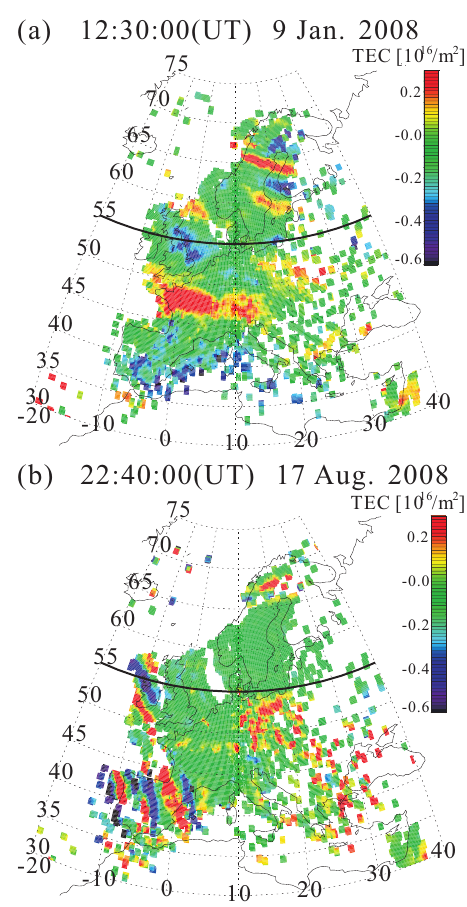
Fig. 2. Two-dimensional maps of TEC perturbations observed with GPS networks in Europe (a) at 12:30UT on 9 January 2008, and (b) at 22:40UT on 17 August